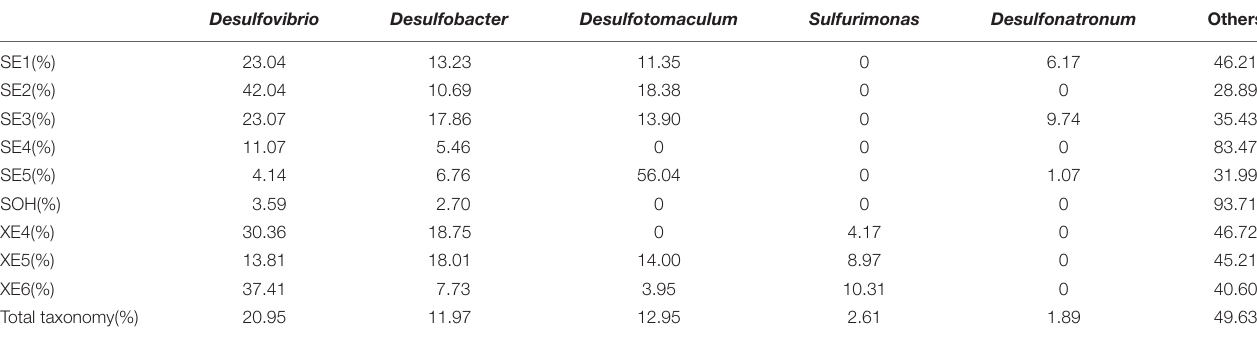
TABLE 4 | Microbial community compositions at genus level. Desulfovibrio Desulfobacter Desulfotomaculum Sulfurimonas